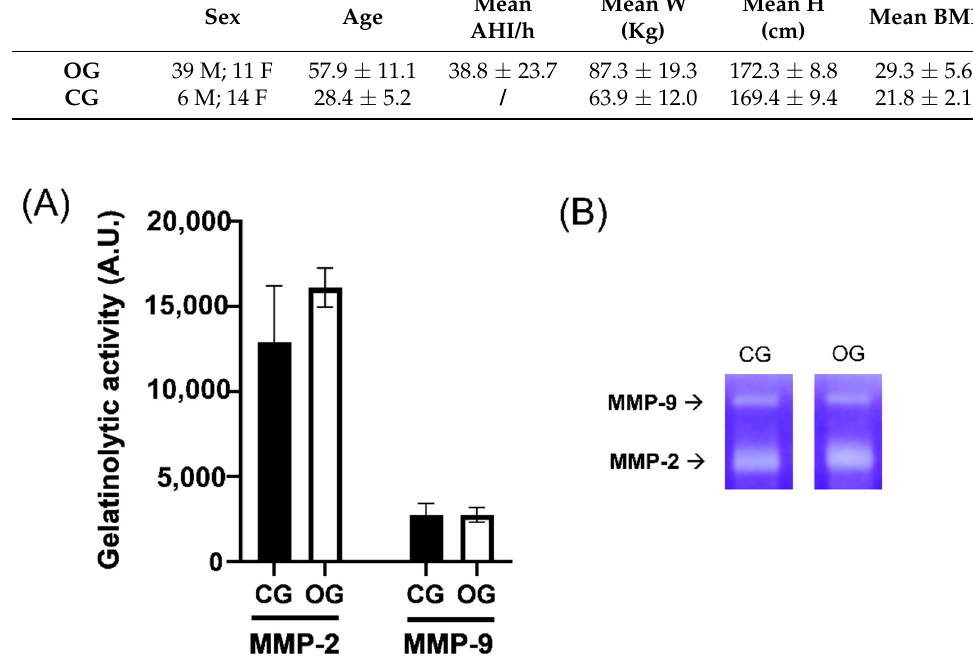
Figure 1. Gelatinolytic activity of MMPs from salivary samples. ( A ) Bar plots of the densitometric analysis of gelatinolytic bands from MMP9 and MMP2 activity. ( B ) A representative zymogram: of the gelatinolytic activity of MMP2, and MMP9 pro-forms of MMP gelatinases of salivary samples from control and OSA group (CG and OG, respectively). The intensities of the gelatinolytic activity areas were measured through IMAGE J free scientific image processing software and quantified using a scale of arbitrary units (AU). Statistical analysis was performed by GraphPad MMP-9 ( p = 0.97) and MMP-2 activity ( p = 0.19).